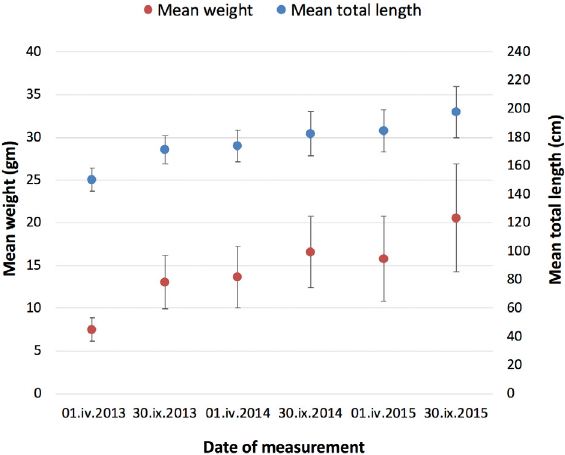
Figure 2. Mean total length and weight of 20 Gharials recorded with respect to warm and cold seasons from April 2013–September 2015. Bars represent standard